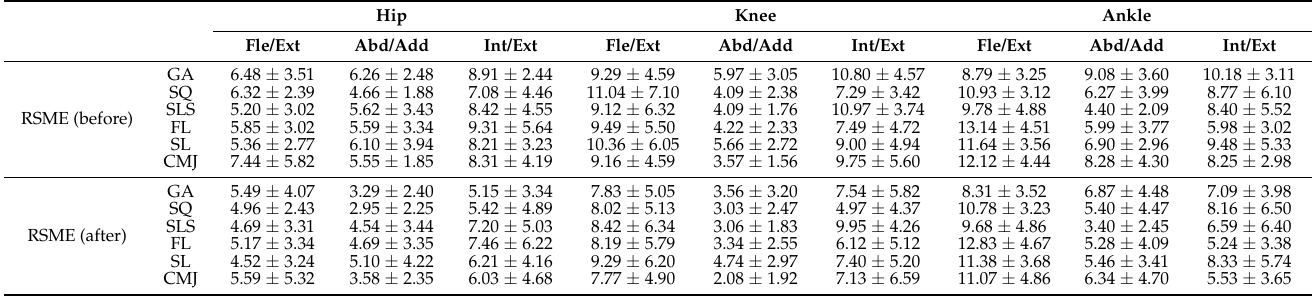
Table 1. Mean root mean square error of Perception Neuron ® and OptiTrack systems in all tasks. Hip Knee Ankle